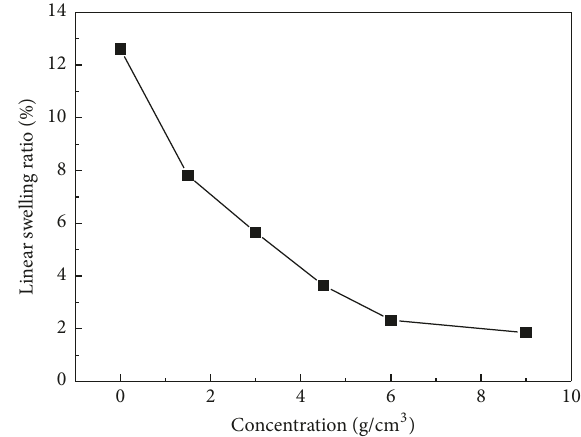
Figure 8: Effect of aqueous polymer concentration on linear swelling ratio of soils.